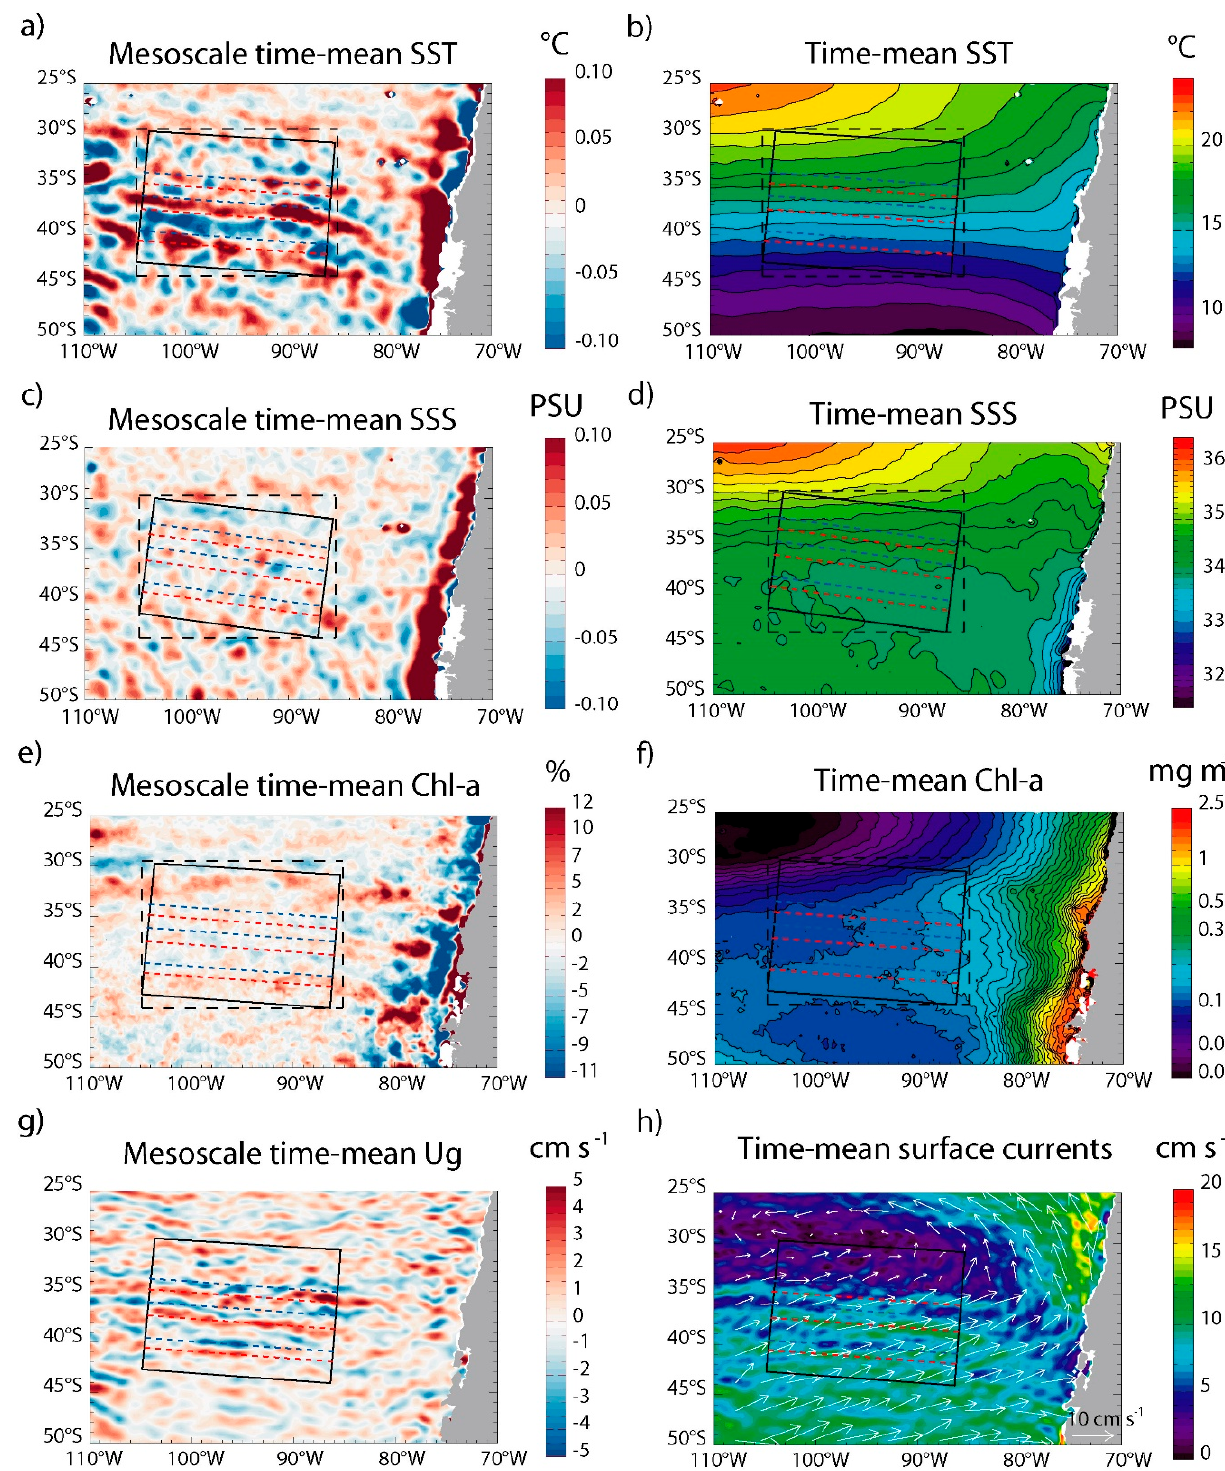
Figure 3. Same as Figure 2, except for the ESP. 2-D FFT is applied inside the black dashed boxes for all the variables. The striation tilt is larger over the 4 April 2015–31 December 2018 averaging period compared to the 2 July 2012–31 December 2018 period (12.7° vs. 5.8°, see Table 2).